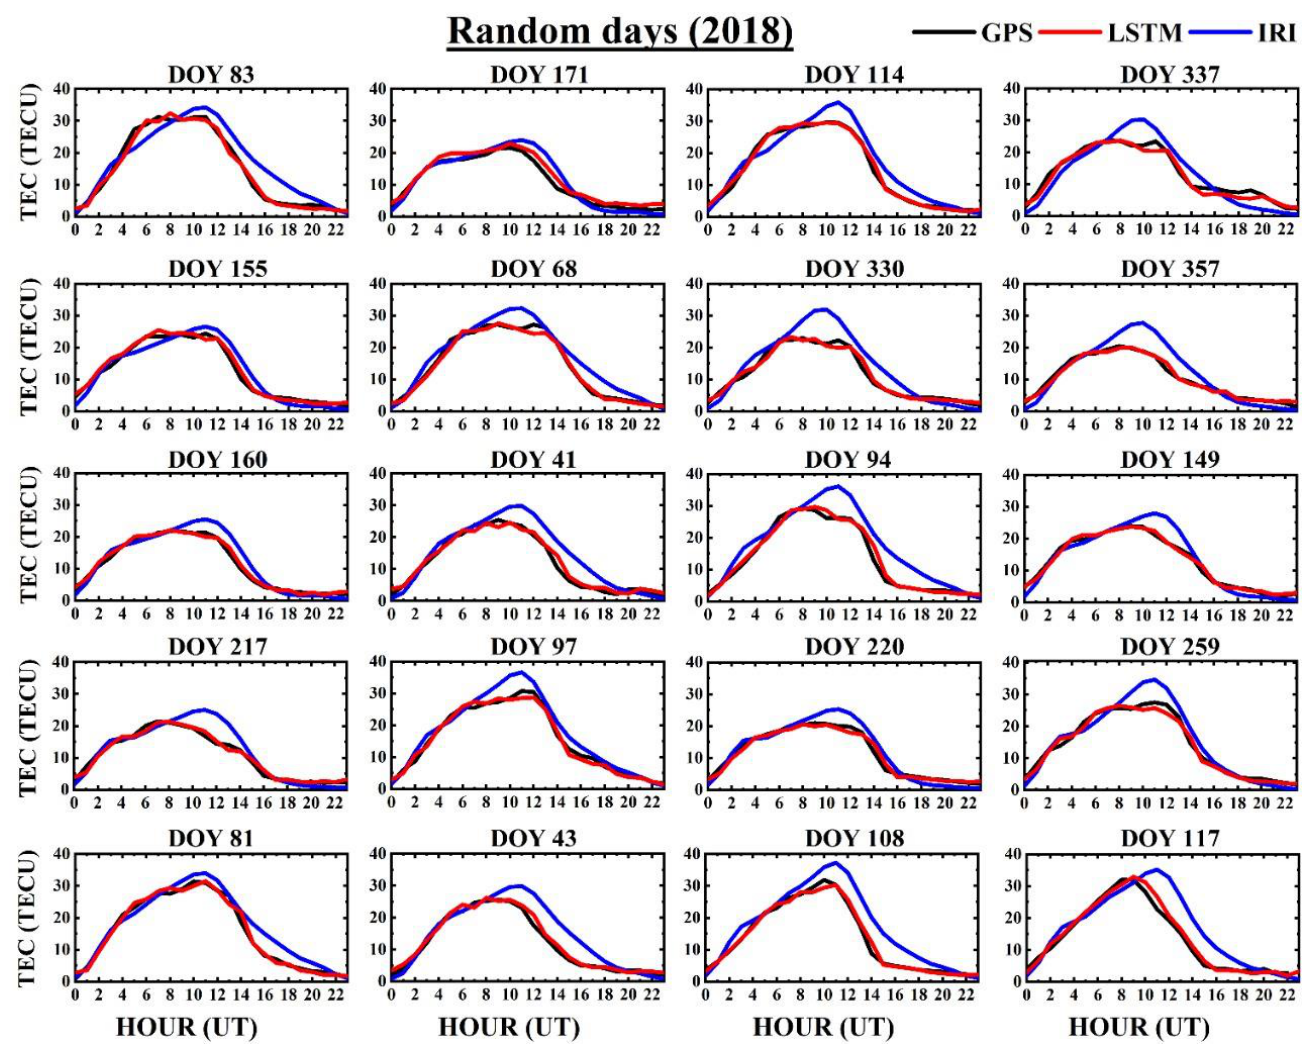
Figure 4. Comparison of the TECs predicted for the random days of the year (DOY) in 2018 by the GPS TEC (black solid line), IRI (blue solid line), and LSTM (red solid line) at a low latitude station Bangalore (IISC) in India.